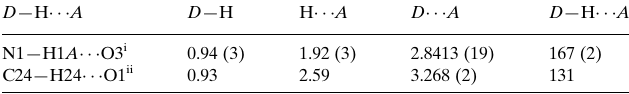
Hydrogen-bond geometry (A˚ , (cid:2)